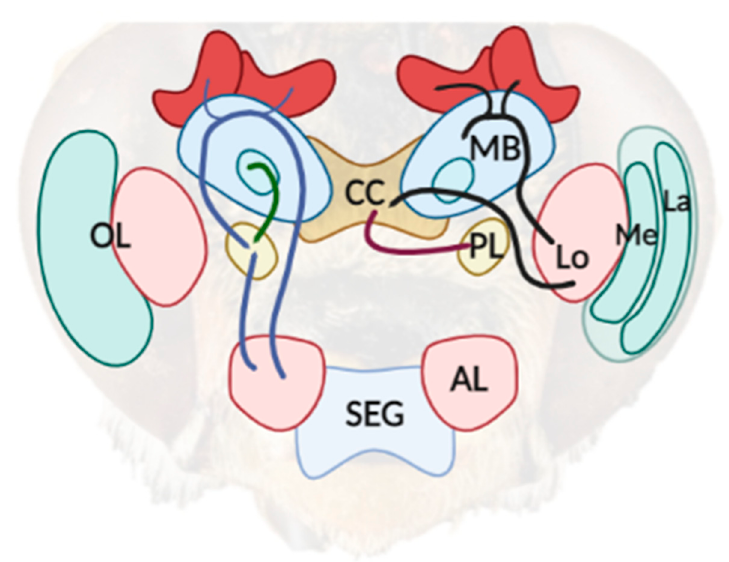
Figure 1. A simplified diagram of the neuroarchitecture of a bee’s brain. The sensory information captured from the compound eye is processed in the optic lobe (OL), which is comprised of the lamina (La), medulla (Me), and lobula (Lo). Two pathways (dark line) can be outlined from the posterior part of the Lo, which project axons to the mushroom body (MB) and to the central complex (CC). The lateral protocerebrum (LP) is involved in the integration of information from several areas in the bee’s brain, including visual information from the CC (purple line) and olfactory information previously processed from the antenna lobes (LB) and MB (blue line). The scheme was created with BioRender.com (accessed on 20 April 2022).